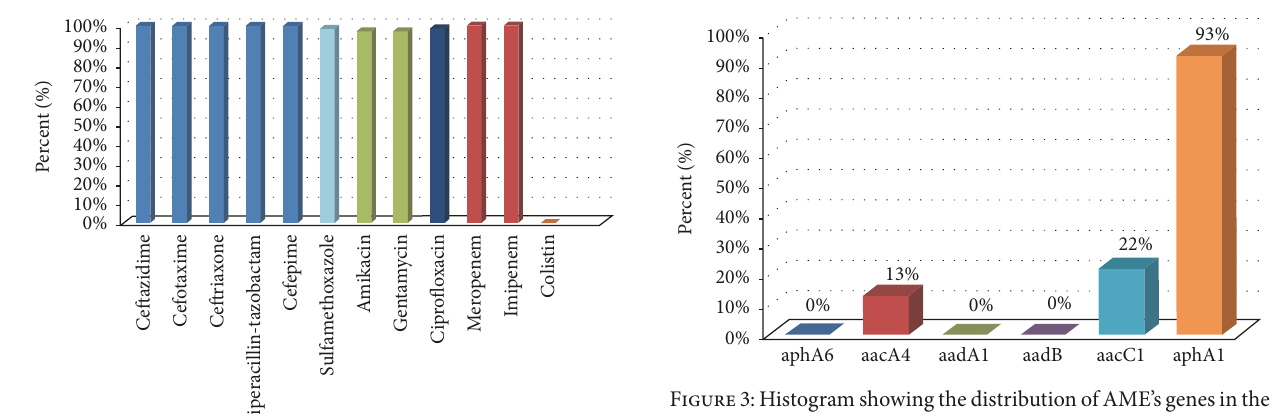
Figure 3: Histogram showing the distribution of AME’s genes in the Acinetobacter isolates